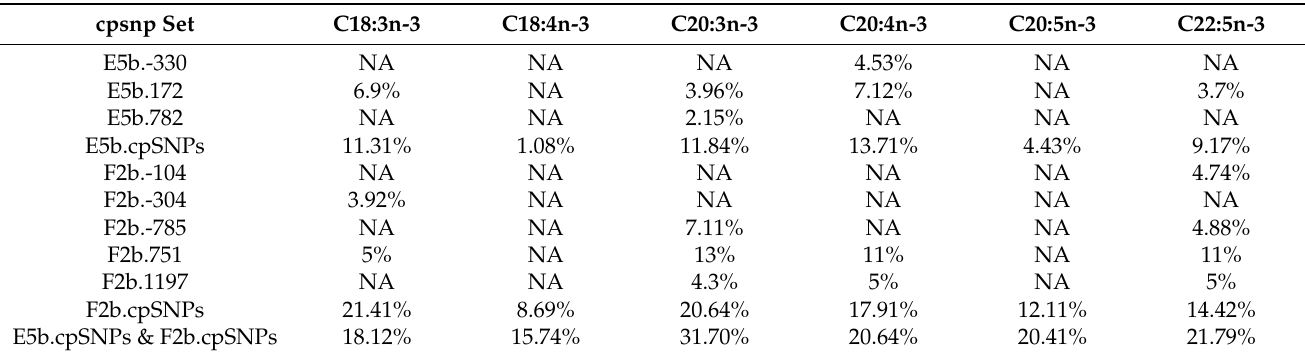
Table 3. The explained PV of cpSNP set on the contents of n-3